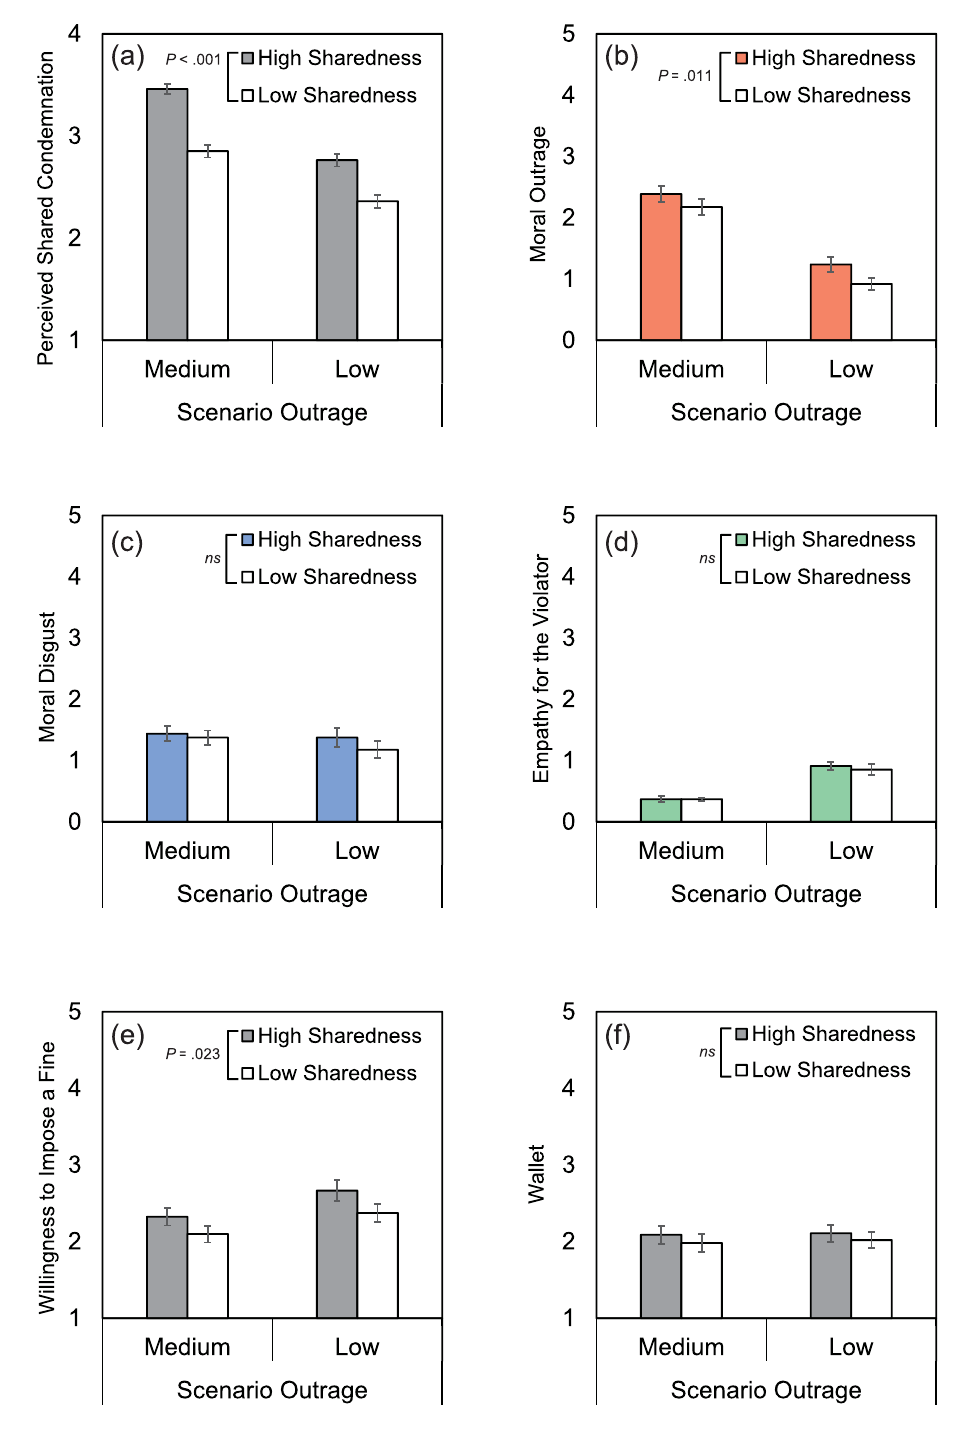
Figure 2. Mean Dependent Variables in Study 2 as a Function of Scenario Outrage (Medium vs. Low) and Information about Others’ Condemnation (High vs. Low). The dependent variables were ( a ) perceived shared condemnation (i.e., manipulation check item in Study 2), ( b ) moral outrage, ( c ) moral disgust, ( d ) empathy, ( e ) willingness to impose a fine, and ( f ) unwillingness to tell about the dropped